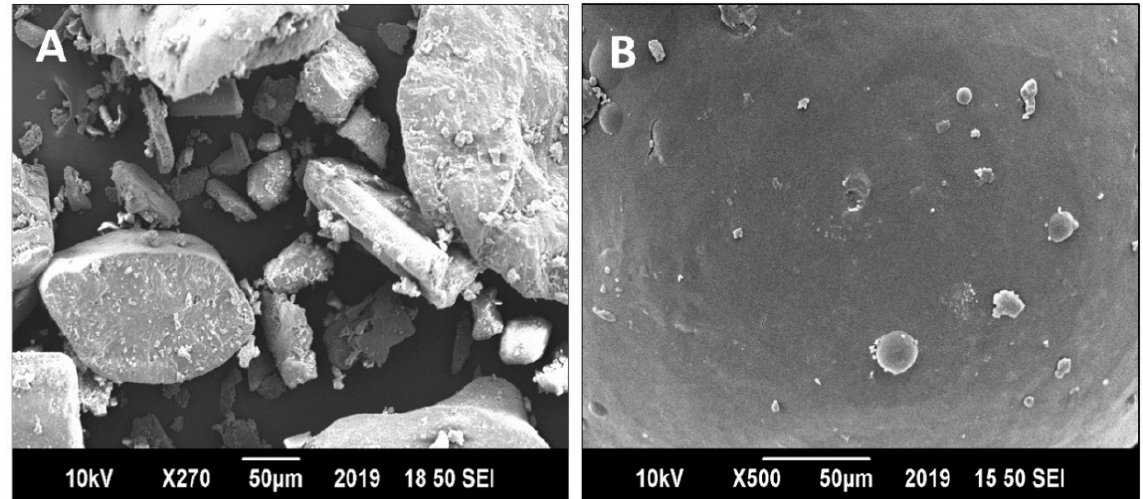
Figure 4. Scanning electron microscopy photographs of ( A ) EBT and ( B ) ETF-5 film.